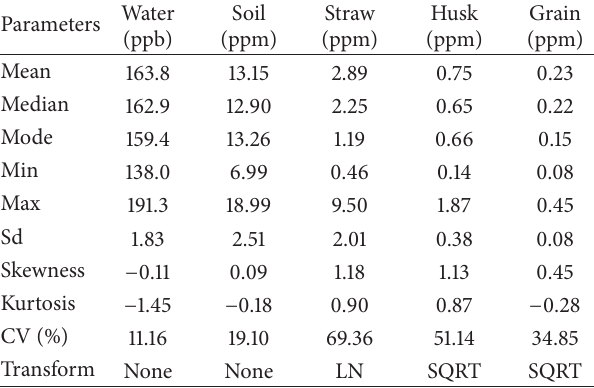
Table 1: Descriptive statistics of water, soil, straw, husk, and grain As of